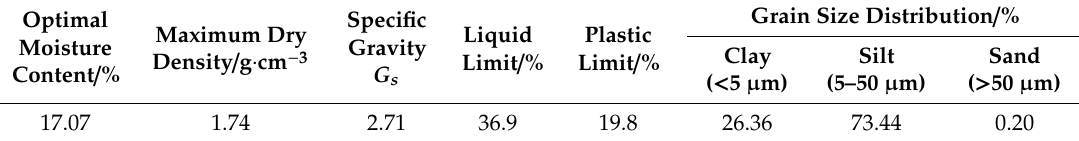
Figure 1. Location map of loess distribution and sampling position in China. ( a ) Distribution of the Table 1. Physical properties of the loess that was used in this study.